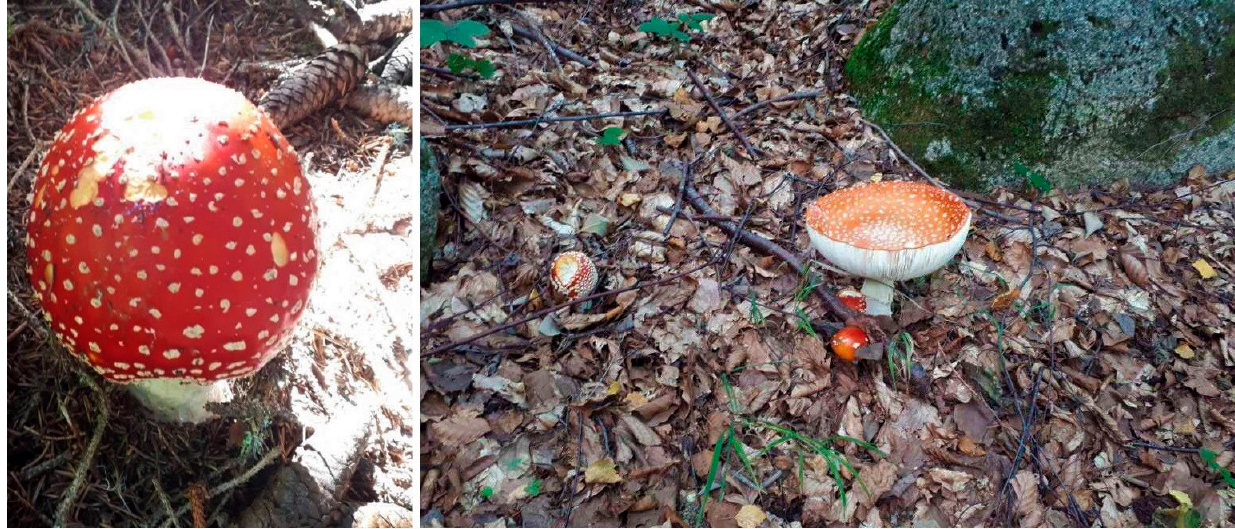
Figure 1. Basidiocarps of A. muscaria observed in the French Prealps (Alpes-de-Haute-Provence, France) (Denis Charret ©).